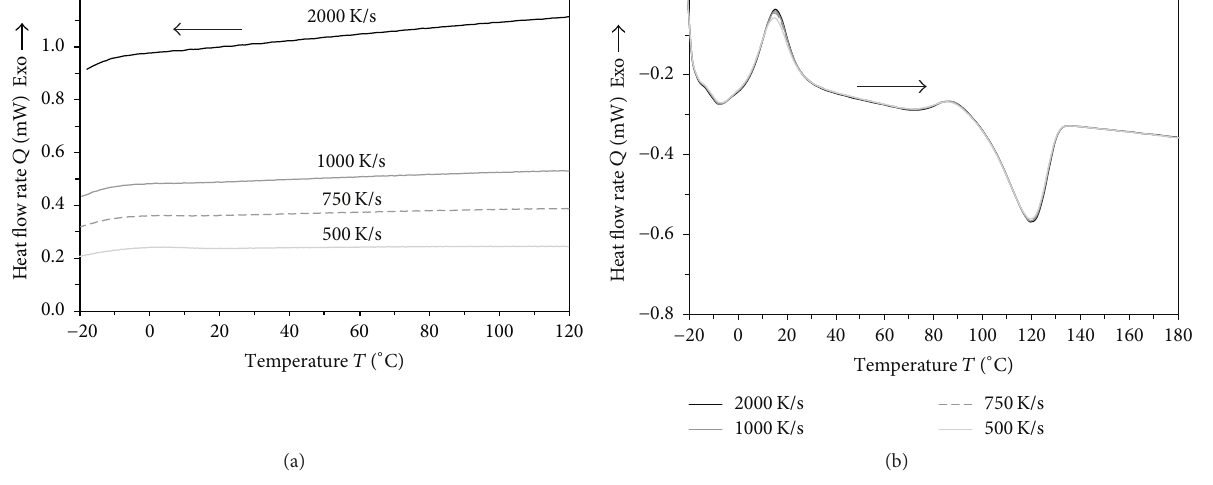
Figure 4: Heat flow rate measured during cooling (a) and second heating (b) of iPP with respect to the examined cooling velocities from 2000 to 500